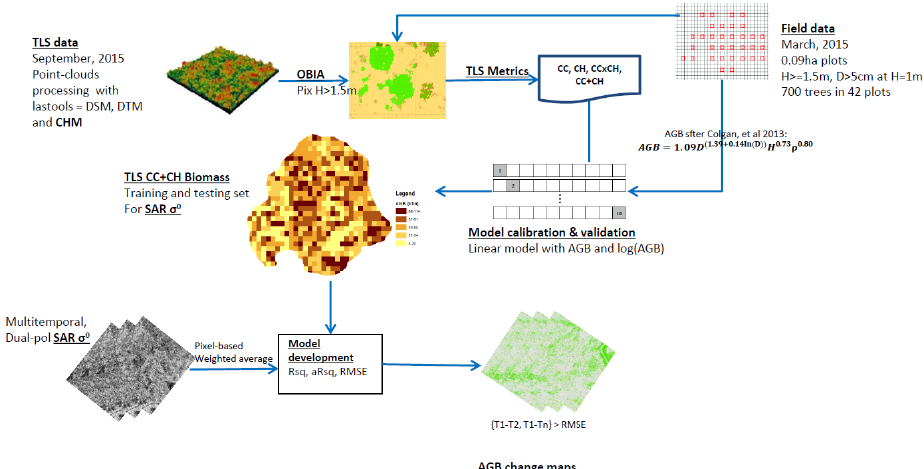
Figure 2. A simplified methodology adopted in modelling aboveground woody biomass for this study. (The acronyms used in the flowchart are: DSM = digital surface model, DTM = digital terrain model, CHM = canopy height model, OBIA = object ‐ based image analysis, Pix = pixel, H = tree height, D = diameter, Rsq = R ‐ squared, RMSE = root mean square error).